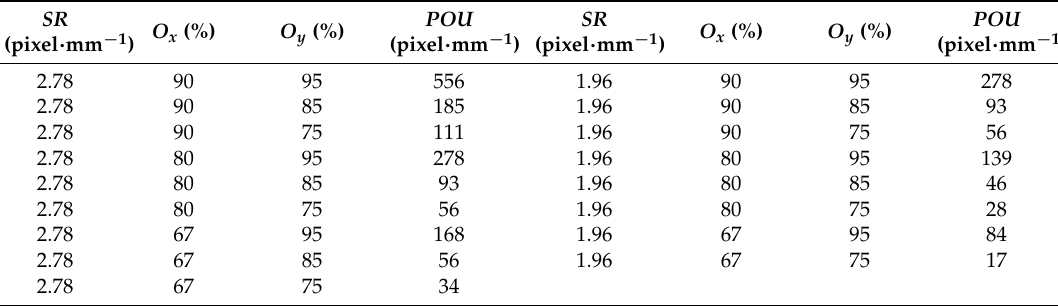
Table 3. POU and its corresponding overlap and spatial